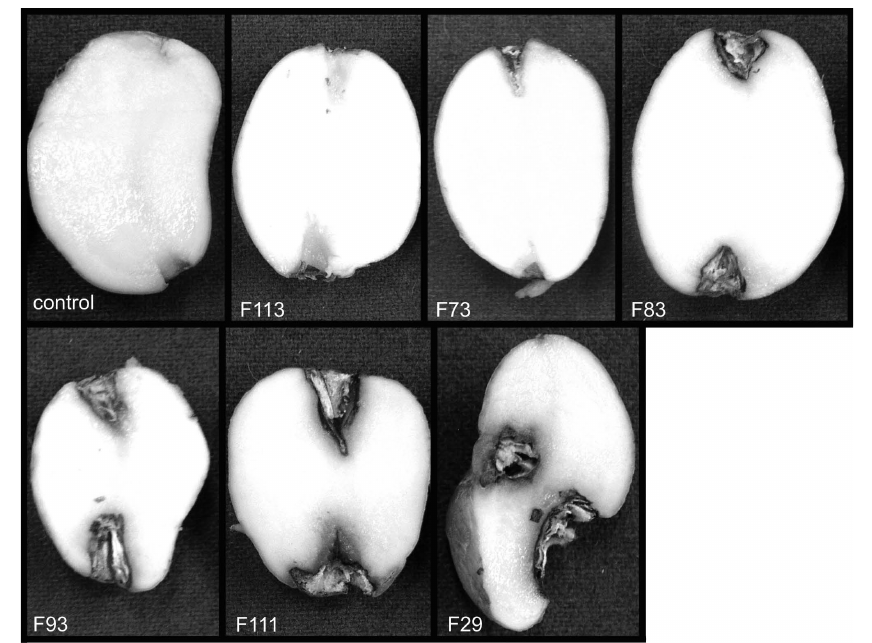
Figure 1. Pathogenicity/virulence of some representative Fusarium solani isolates in potato tubers. Isolates F113 caused the lowest (0) and isolate F29 the highest (5) amount of rotted area. There was no significant difference between F113 (non-pathogenic) and the